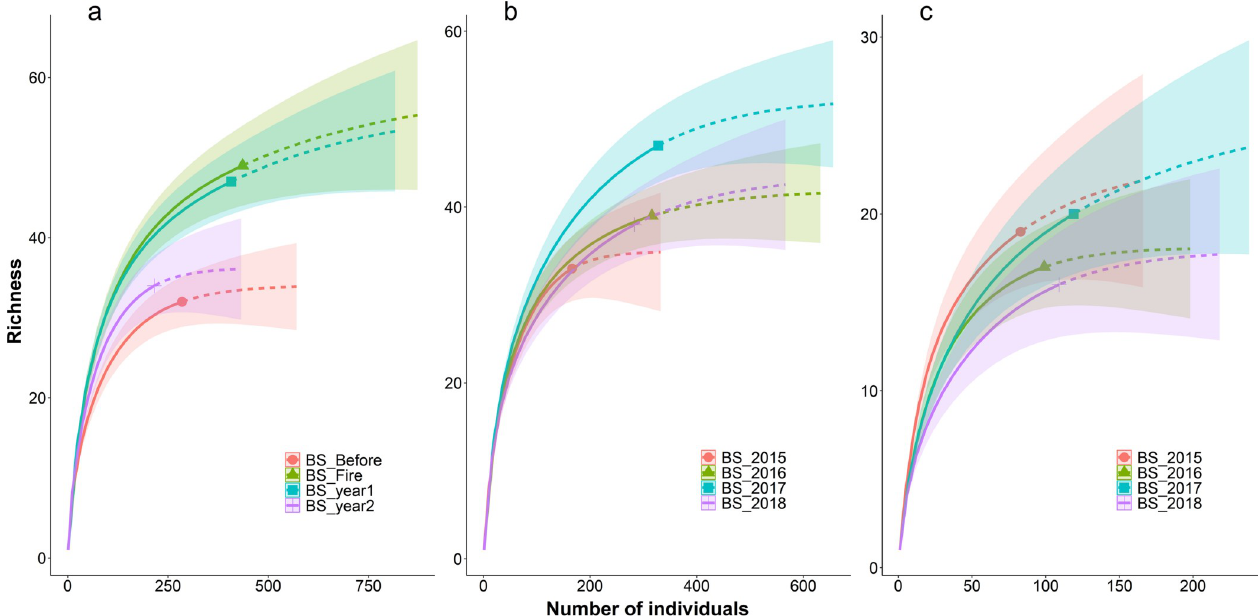
Fig 2. Species richness of birds recorded during four breeding seasons (BS) in grasslands with three histories of fire disturbance in northeastern Rio Grande do Sul state, Brazil. Histories of fire disturbance are occasional fire (a), annual fire (b), and without fire (c). In occasional fire breeding seasons refer to the year before the burn (before), in the year of the burn (fire), and one and two years post-fire (year1 and year2, respectively). Solid and dashed lines are interpolated and extrapolated data, respectively, based on rarefaction and extrapolation method, with their associated 95% confidence